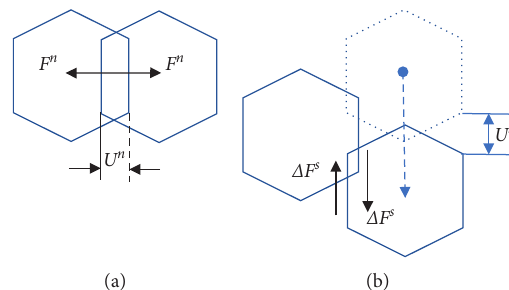
Figure 1: Diagram of the contact relationship between blocks. (a) Normal contact. (b) Tangential